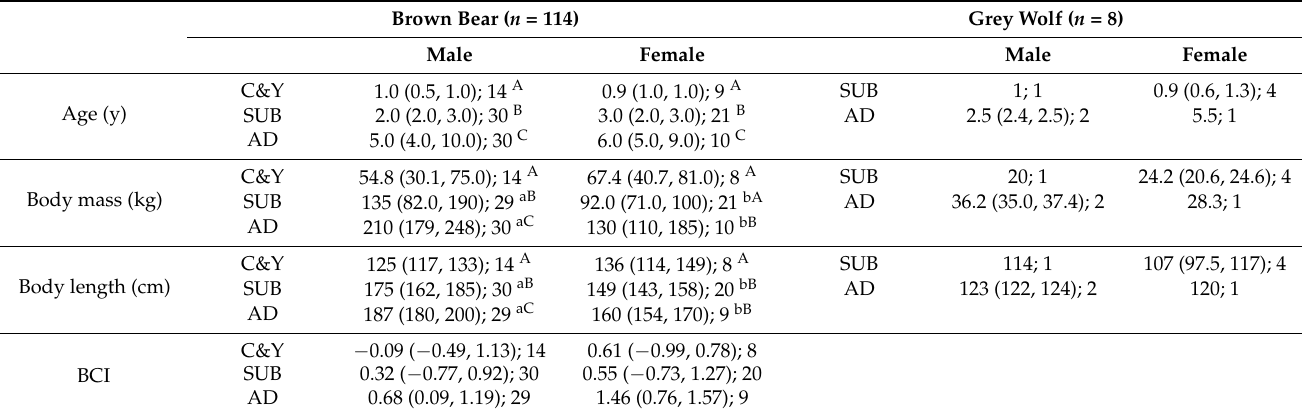
Table 1. The biometric data (median (IQR: Q1, Q3); N) of brown bears and grey wolves from Croatia categorized by sex and age group 1 .